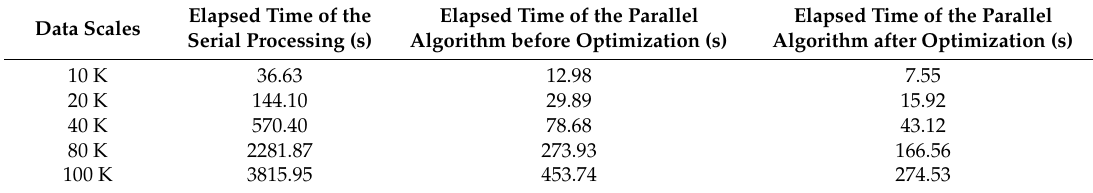
Table 8. Comparison of the elapsed time of the parallel algorithm and its optimized algorithm. Data